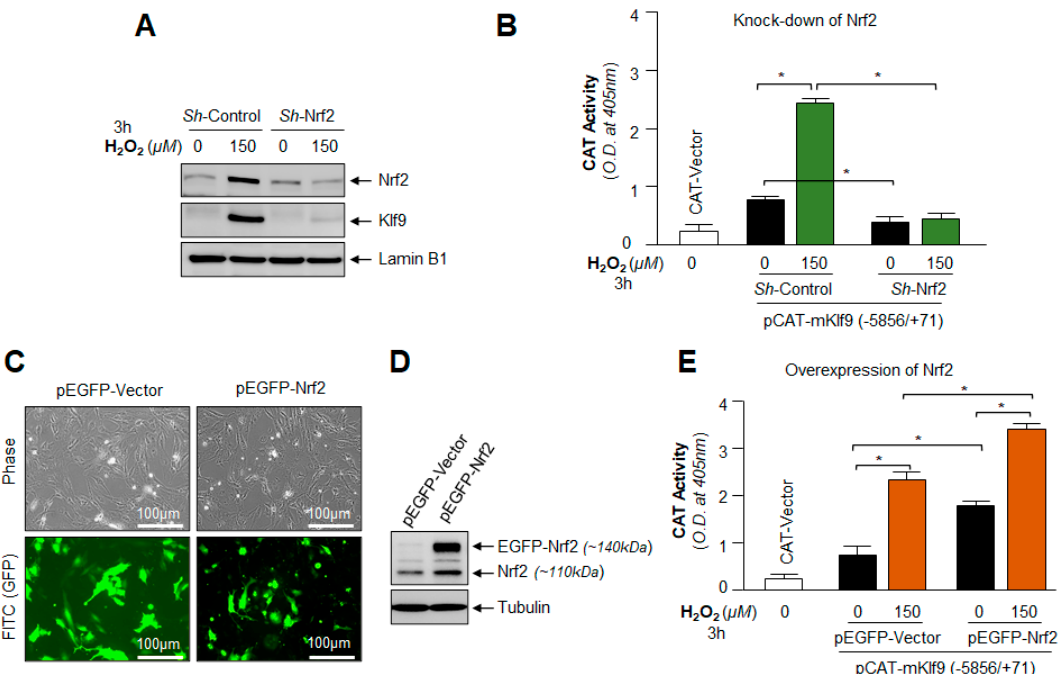
Figure 11. Loss and gain experiments of Nrf2 disclosed that altered Klf9 expression and its promoter activity was directly linked to cellular levels of Nrf2. ( A , B ) Nrf2 -deficient hLECs fails to activate the Klf9 expression and its transcription. ( A ) Nrf2 -depleted hLECs were exposed to H 2 O 2 as indicated in Figure 3A for 3 h. Nuclear extract were prepared, and equal amount of protein was immunoblotted using an antibody specific to Nrf2 or Klf9. ( B ) Nrf2 -deficeint hLECs were transfected with WT Klf9 promoter ( − 5856/+71) linked to CAT vector. The transfectants were exposed to H 2 O 2 for 3 h as shown, and Klf9 promoter activity was measured and shown. Data are the mean ± S.D. of three independent experiments. * p < 0.001; H 2 O 2 treated versus control and Sh -Nrf2 vs. Sh - Control. ( C – E ) Nrf2 overexpression enhanced the Klf9 promoter activity. ( C ) Photomicrograph representing the Nrf2 overexpression in hLECs, left panel: pEGFP-Vector; right panel: pEGFP-Nrf2. ( D ) Western blot analysis showing the Nrf2 overexpression of transfected cells. Cellular extract prepared from pEGFP-Vector and pEGFP-Nrf2 overexpressed hLECs having equal amount of protein was immunoblotted with antibody specific to Nrf2. ( E ) Cells overexpressing Nrf2 showed enhanced Klf9 transcription. hLECs were transfected with Klf9 promoter ( − 5856/+71) along with pEGFP-vector and/or pEGFP-Nrf2 plasmids. 48 h later transfectants were exposed to H 2 O 2 for 3 h, and promoter activity was monitored. Data are the mean ± S.D. of three independent experiments. * p < 0.001; H 2 O 2 treated versus control and pEGFP-Nrf2 vs.